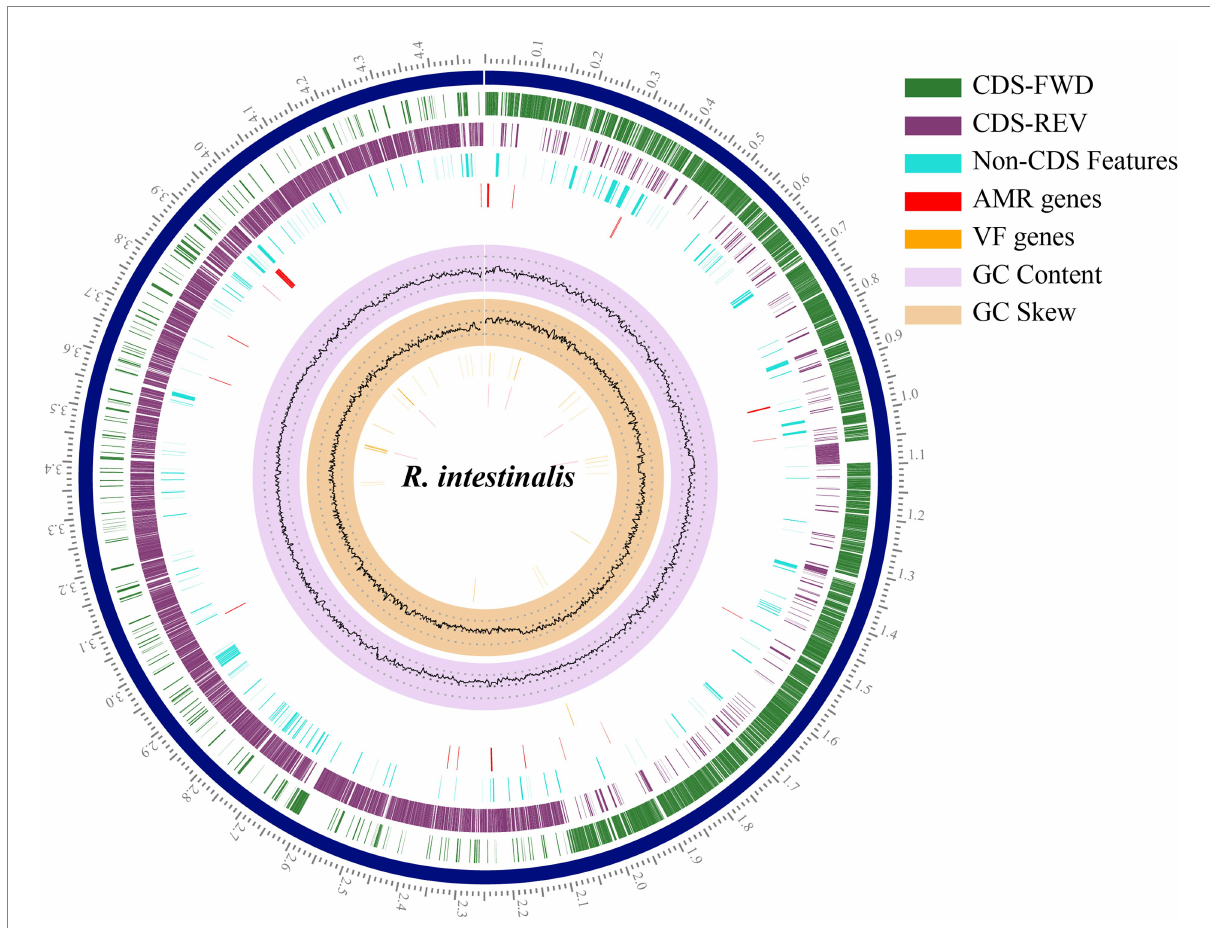
FIGURE 2 Circular genome map of Roseburia intestinalis . The outermost scales indicate the base location in Mbp. From the innermost circles: GC skew, GC content, virulence factor genes, AMR genes, Non-CDS features. The last two circles illustrate the coding sequence, the green circle represents the forward strand, and the purple circle represents the backward